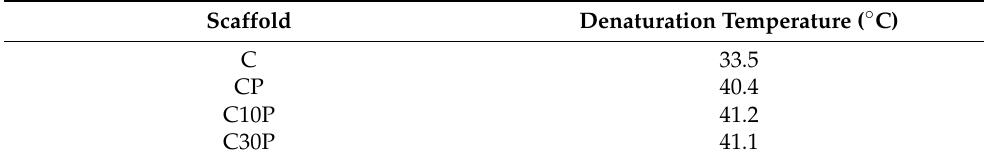
Table 2. Denaturation temperature (Td) for the scaffolds .